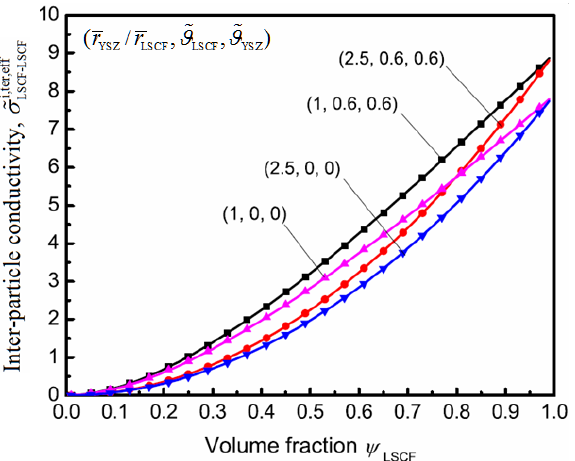
Figure 10. The effective non-dimensional inter-particle ionic conductivity as a function